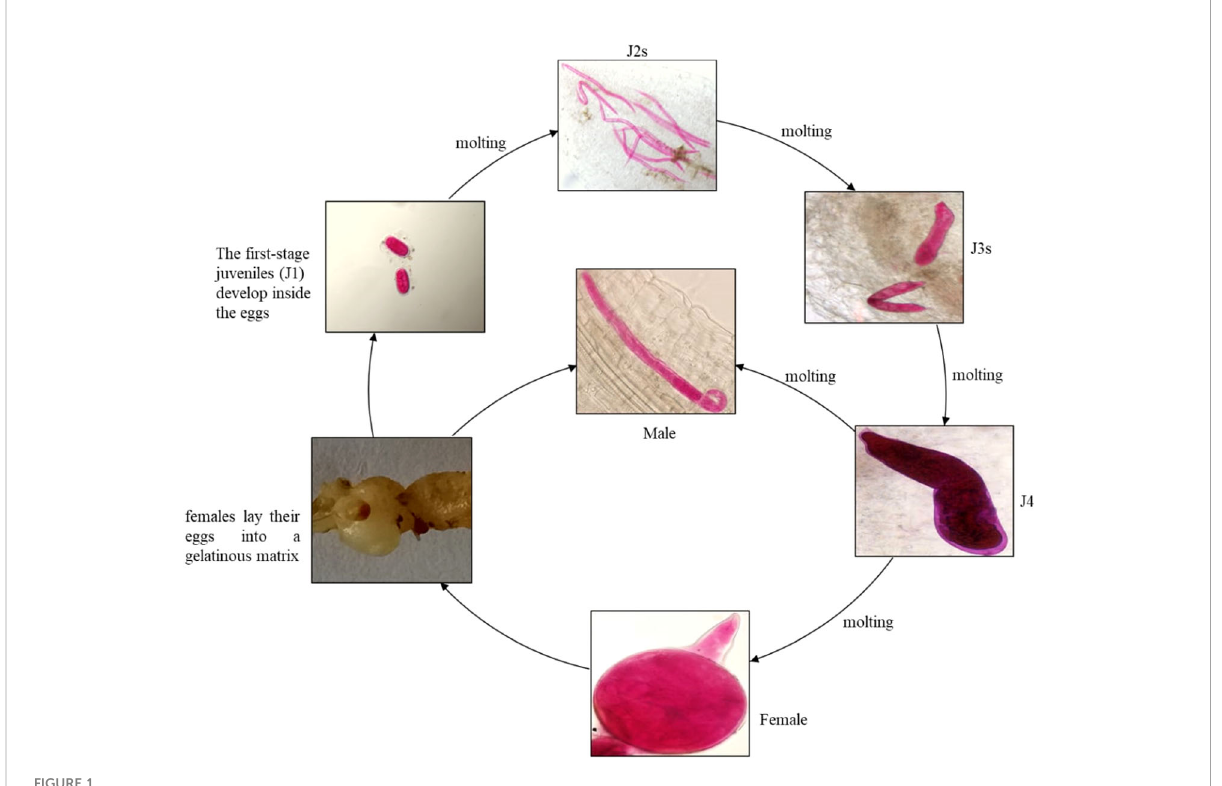
FIGURE 1 Life cycle of Meloidogyne